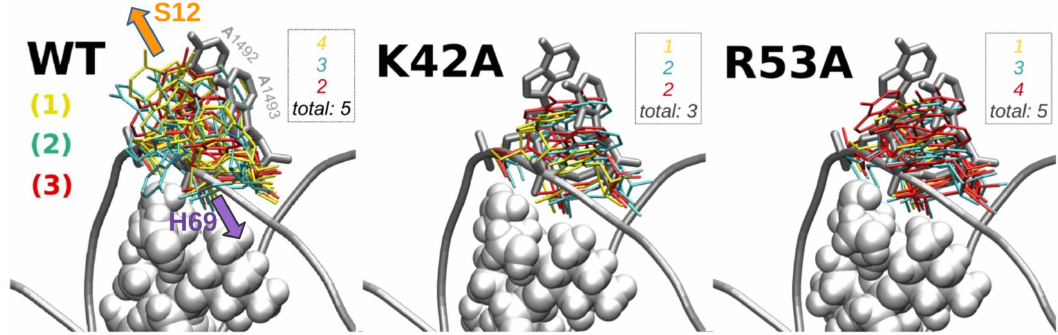
Figure 6. Representative MD conformations of A1492 and A1493 in the variants with paromomycin. Cluster representatives from three MD trajectories (different colors) were superimposed on the crystal structure of the E. coli ribosome bound to mRNA and A-site tRNA [7] (PDB 3I1Z). Paromomycin is represented as vdW spheres. The numbers of conformational clusters of A1492 and A1493 for each MD run are listed in each panel as an inset (color-coded as simulation numbers in panel [a]); the total number of conformational clusters is given, from clustering of frames from all three independent MD trajectories for a given simulation variant. Violet and orange arrows indicate the general directions taken by S12 and H69, with respect to A1492 and A1493.